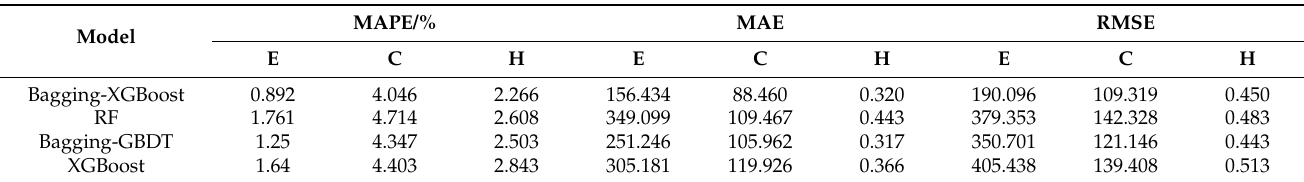
Table 7. Comparison of indicators of different forecasting